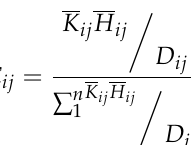
Figure 7. The producer – injector relationship coefficient of the target well pattern in this study.